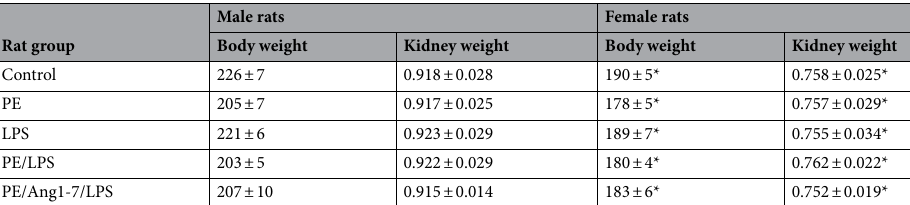
Table 1. Values of body and kidney weights (in grams) in adult offspring of control (non-PE) and PE rats. Values are presented as means ± SEM of 6–8 observations. *P < 0.05 vs. respective values in male